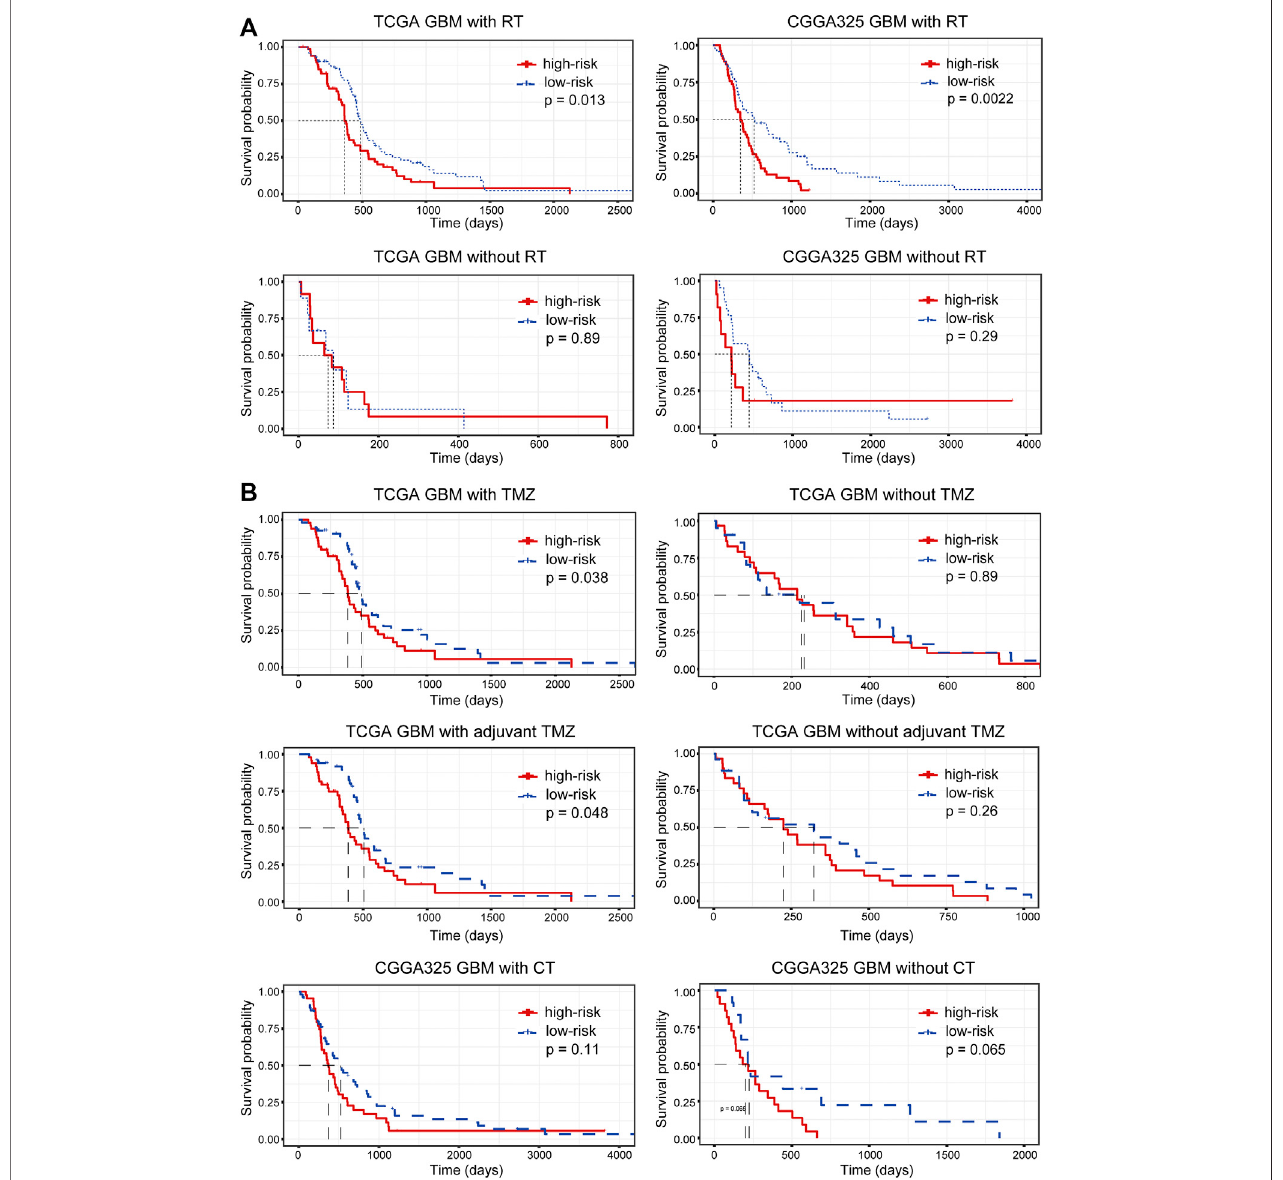
FIGURE 7 | The relationship between risk strati fi cation and the ef fi cacy of (A) radiotherapy and (B) chemotherapy. RT, radiotherapy; TMZ, temozolomide; CT, chemotherapy.